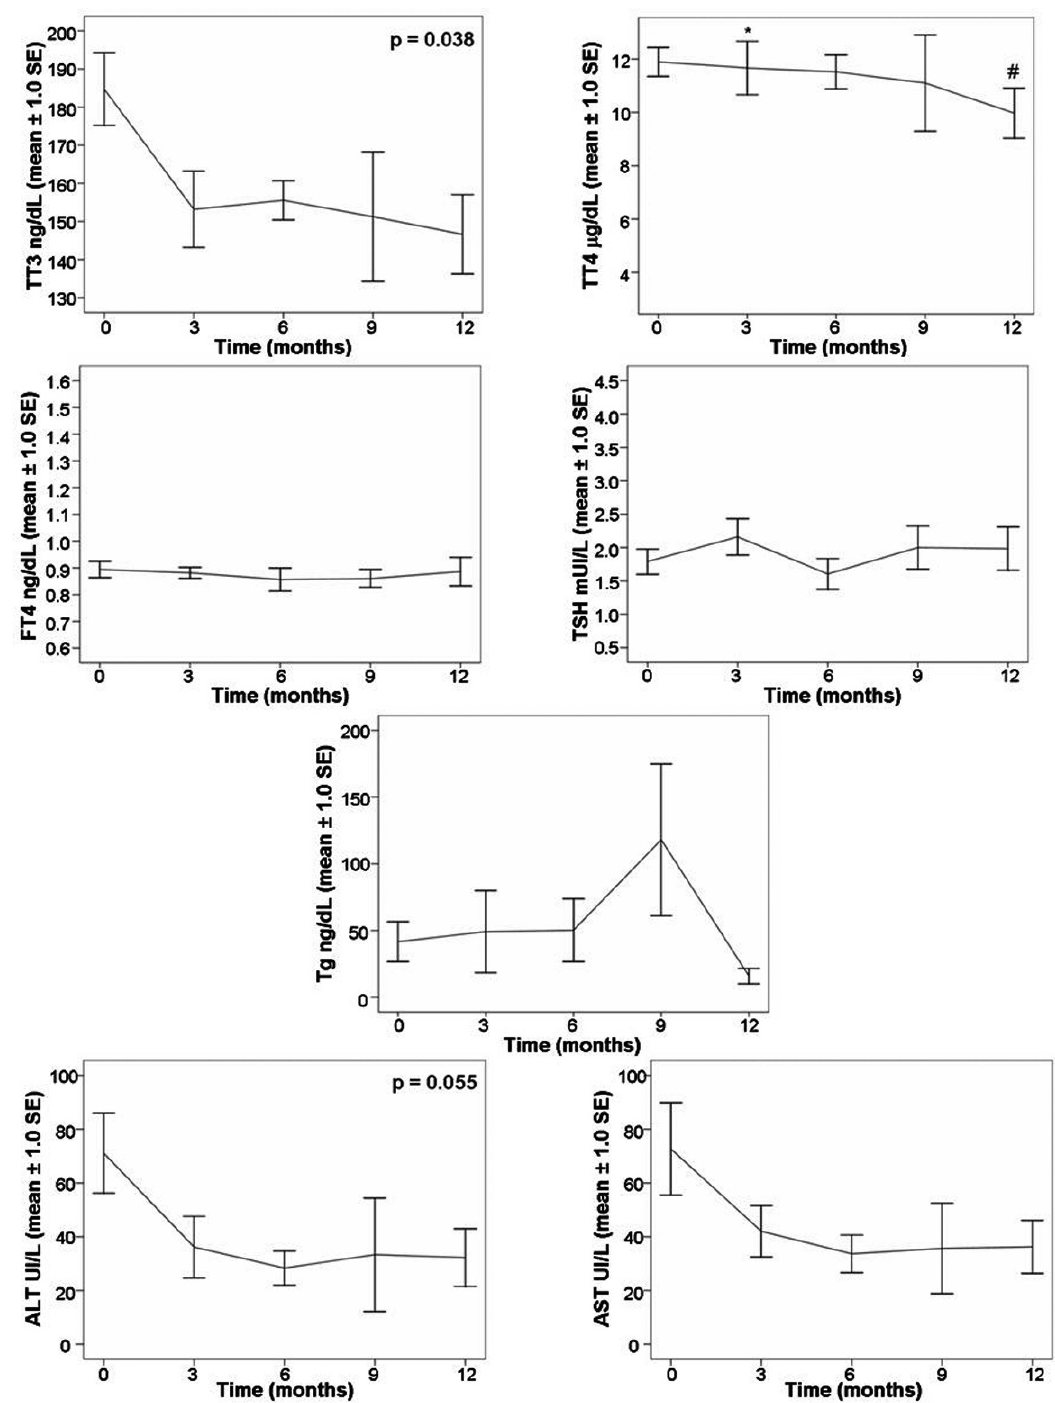
Figure 1 - Hormonal, thyroglobulin, and aminotransferases changes during the 12-month follow-up of 14 HCV-infected patients with normal thyroid function during IFN a and ribavirin treatment. Differences were assessed using Kruskal-Wallis tests. * p =0.039 compared to the initial levels. # p =0.008 compared to the initial levels. Reference values: TT3, 40 to 180 ng/dL; TT4, 4.5 to 12 m g/dL; FT4, 0.7 to 1.5 ng/dL; TSH, 0.4 to 4.5 mUI/L; Tg , 55 ng/dL (by fluoroimmunoassay); AST , 37 or , 31 UI/L and ALT , 41 or , 31 UI/L for males or females, decreases in TT3 and TSH levels along with an increase in decrease in TT3 and TT4 levels during treatment may be reverse T3 levels without any change in TT4 or FT4 levels. related to the improvement of the hepatocellular lesions, as They attributed the hormonal changes to increases in IL-6 indicated by the reduction in ALT levels. Unfortunately, we levels and interferon-induced cortisol release. Finally, the did not evaluate thyroxine-binding globulin (TBG) to confirm